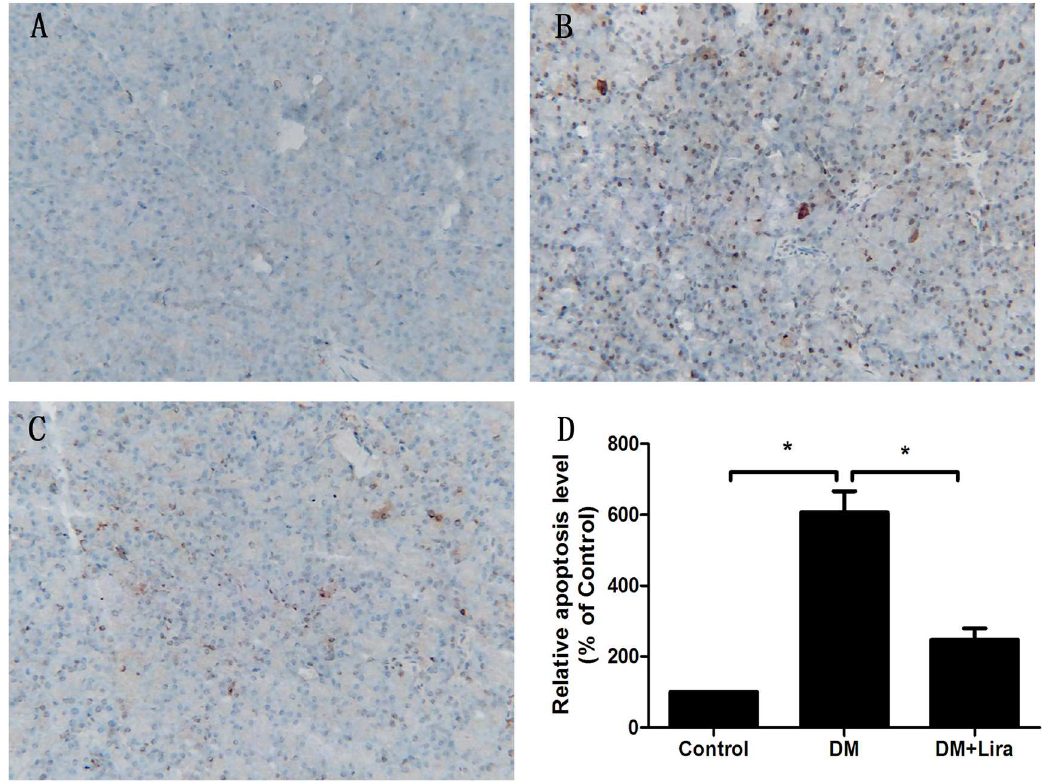
Fig 2. Cell apoptosis of rat pancreatic tissue from the control group (A), DM group (B), and DM + liraglutide group (C) assessedby TUNEL staining. TUNEL-positive regions are brown. Fig 2D shows the relativelevels of apoptosisin the three groups. Diabeticrats were dividedinto two groups, administered without (DM group) or with liraglutide(DM + Lira group) at a dose of 200 μ g/kg/d. SD rats of control group were fed with normalchew and received subcutaneous injectionof saline (Controlgroup, DM group, and DM + liraglutidegroup; 100%, 606.3 ± 59.9%, 247.7 ± 31.8%, n = 5, p <